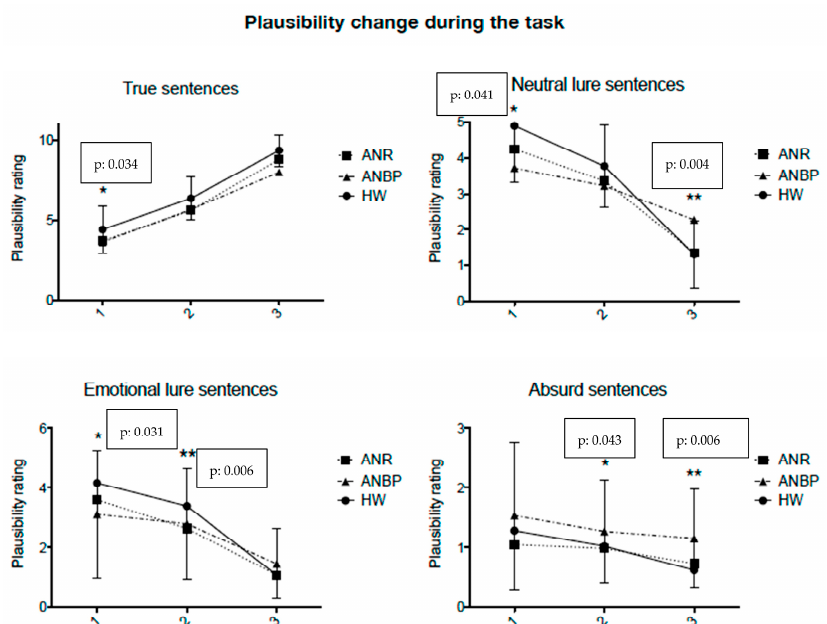
Figure 2. Changes in plausibility rating during the task in healthy women and two clinical groups: ANR and ANBP for the four different types of scenarios. Note: 1, 2, 3: first, second, and third statements progressively adding information to the scenarios as the task progresses; Kruskal–Wallis test; * p < 0.05; ** p < 0.01. The error bars indicate the SEM.